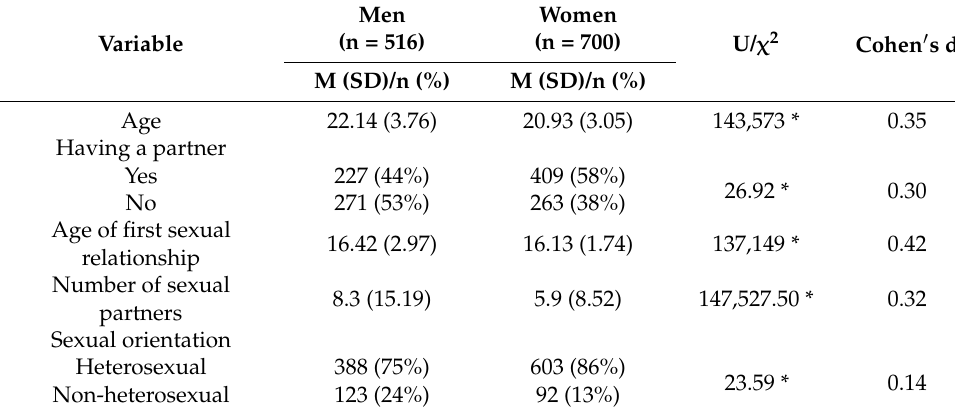
Table 1. Sociodemographic characteristics of the sample from Study